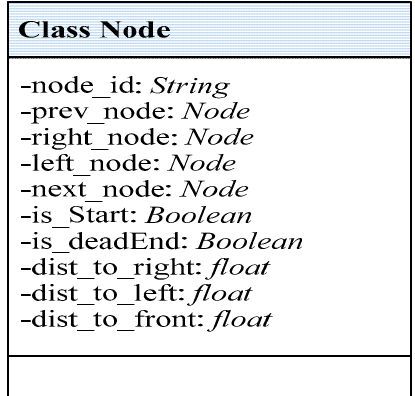
Figure 2. Class node attributes.